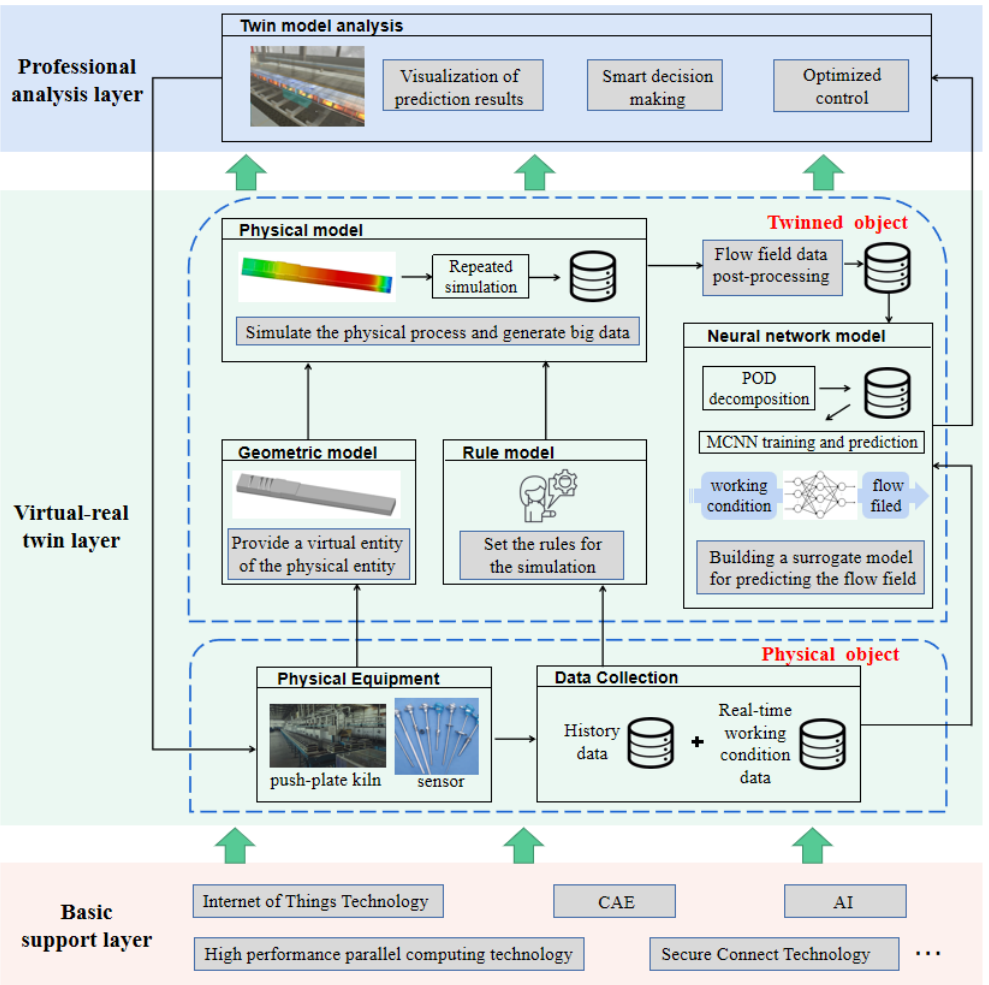
Figure 2. General framework of the CFD digital twin.